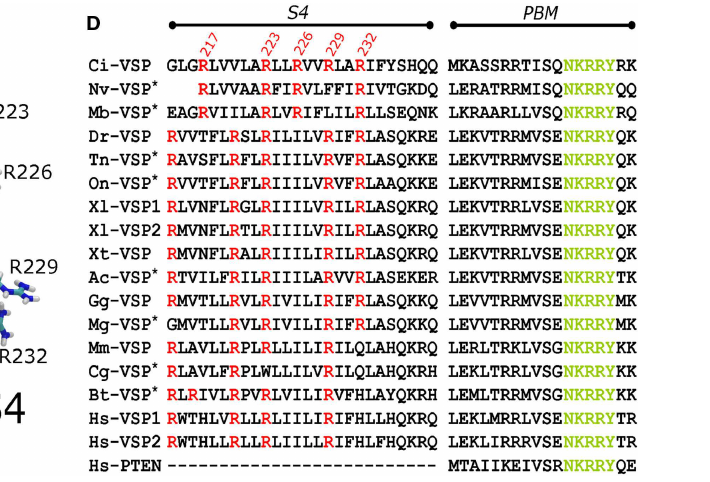
FIGURE 2 |A structural model for the Ci-VSPVSD was generated using the package MODELER and the structure of the chimeric potassium channels Kv1.2–2.1 (2R9R), subjected to minimization and an all-atom simulation for 50ns using NAMD. For molecular dynamics simulations, the structure was embedded in a DPPC lipid bilayer (not shown). (A) Top view displaying four transmembrane segments (S1–S4) in counterclockwise order. (B) Side view of the Ci-VSPVSD model.The S4 segment displays five Arginines. Arginines 223, 226, 229, and 232 (R1–R4) are located in the center of the crevice formed by the packing of the helices. In contrast, Arginine 217 remains outside the crevice pointing toward the lipids. (C) S4 segment shown in details. All charged residues point to the center of the crevice (right side), except for R217 which faces the opposite direction. (D) Alignment of the S4 segment ofVSP from several species.The PBM, particularly, the sequence